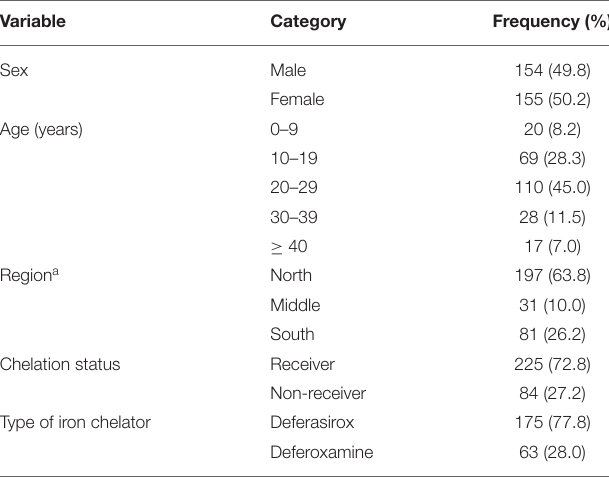
TABLE 1 | Demographic characteristics and iron chelation therapy status of β -thalassemia